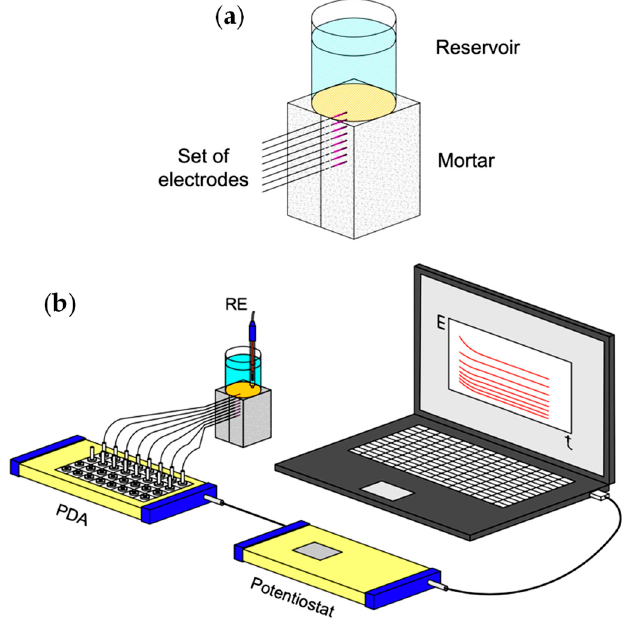
Figure 1. ( a ) Sketch of the pH sensors or Fe wires embedded in the mortar sample. ( b ) Experimental set-up for monitoring the pH or the corrosion potential of Fe wires inside mortar during exposure to the sulfuric acid